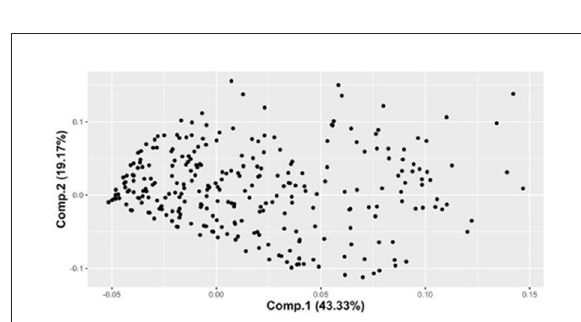
FIGURE7 Score plot of cats on the first (PC 1) and second (PC 2) principal components, with the increase of thunderstorms.